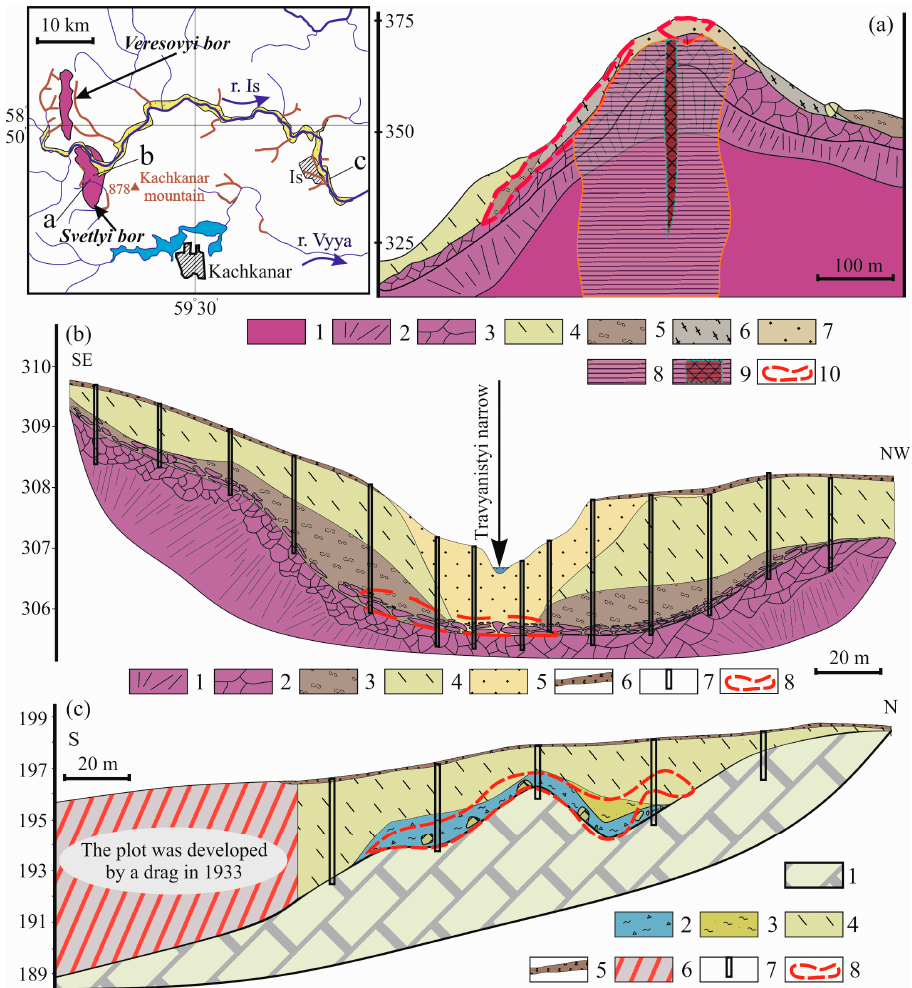
Figure 2. On the map are the rivers Is and Viya, Is and Kachkanar villages, as well as the sampling sites: Vershinniy eluvial ( a ), Travyanistyi proximal ( b ) and Glubokinskoe distal ( c ) placers. Platinum placers are designated by brown ( a ): 1—dunites, 2—serpentinized fractured dunites, 3—weathered serpentinized dunites, 4—sediments of temporary watercourses, 5—clay-eluvial sediments, 6—eluvial with low clay amount, 7—eluvial, 8—vein-disseminated chromitites, 9—massive chromitites, 10—the contour with the platinum content of more than 200 mg/m 3 . ( b ): 1—serpentinized fractured dunites, 2—weathered serpentinized dunites, 3—clay-eluvial sediments, 4—sediments of